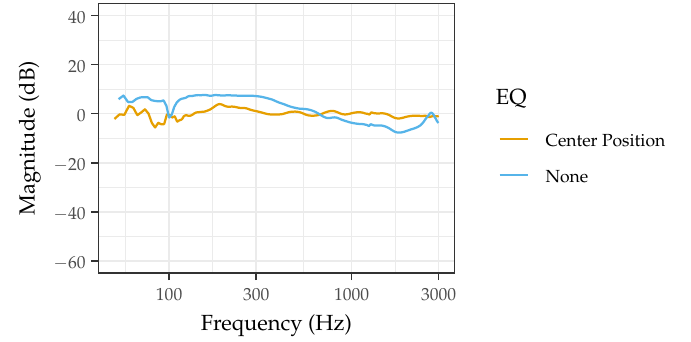
Figure 6. Frequency response measured from the center position of the acoustic phantom with and without equalization